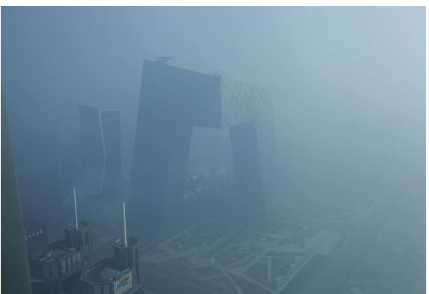
Figure 2: Nanomasks on non-woven